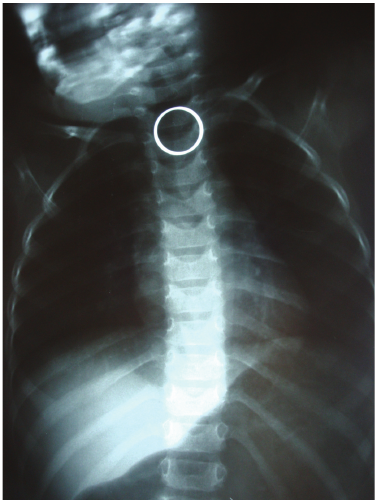
Figure 1: A radiopaque FB (a wedding ring).